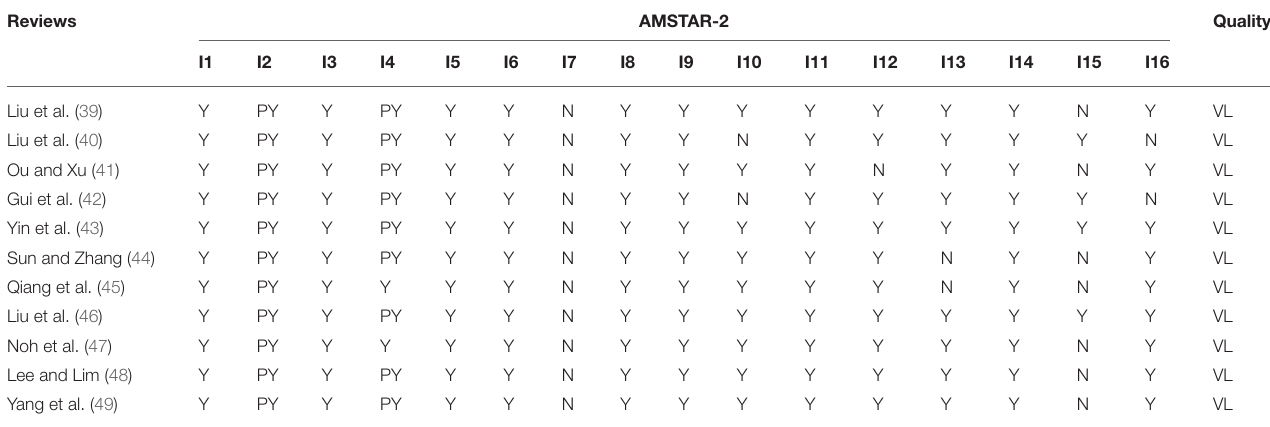
TABLE 3 | Result of the AMSTAR-2